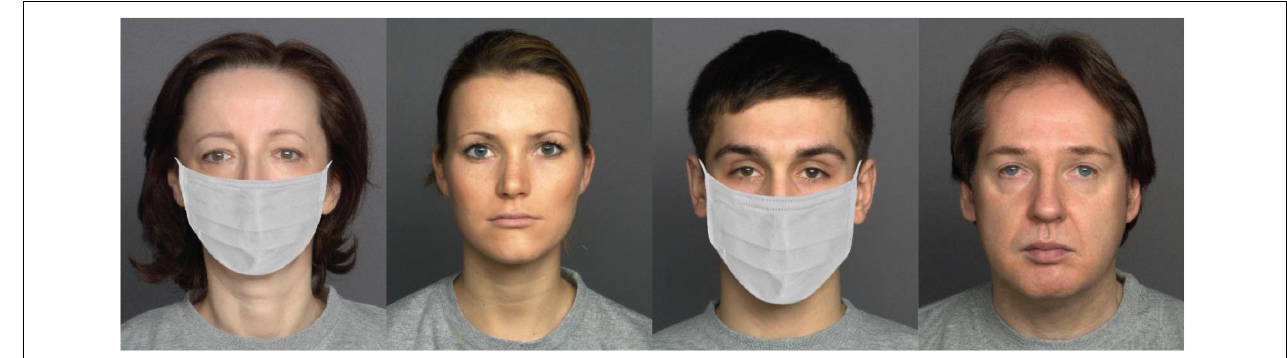
FIGURE 1 | Sample neutral faces used in the survey. Eight faces were used in the experiment. Four of the faces were shown here. There was a no-masked and a masked version for each